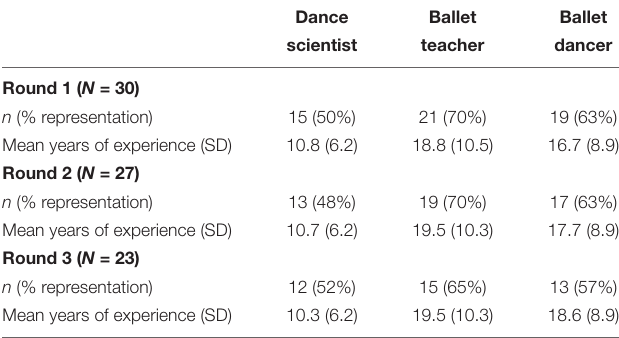
TABLE 1 | Representation of each expert category and years of experience. Dance Ballet Ballet